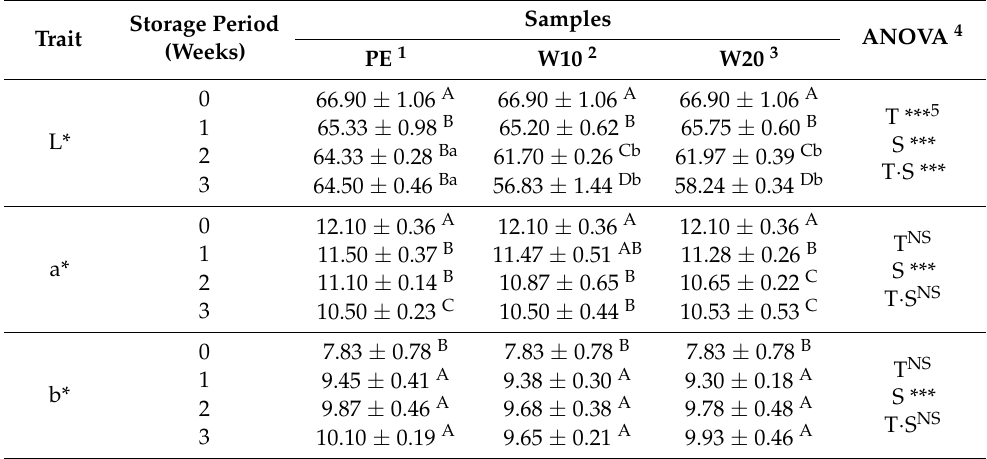
Table 5. Color of sausages stored in the PE and biodegradable container manufactured with walnut shell